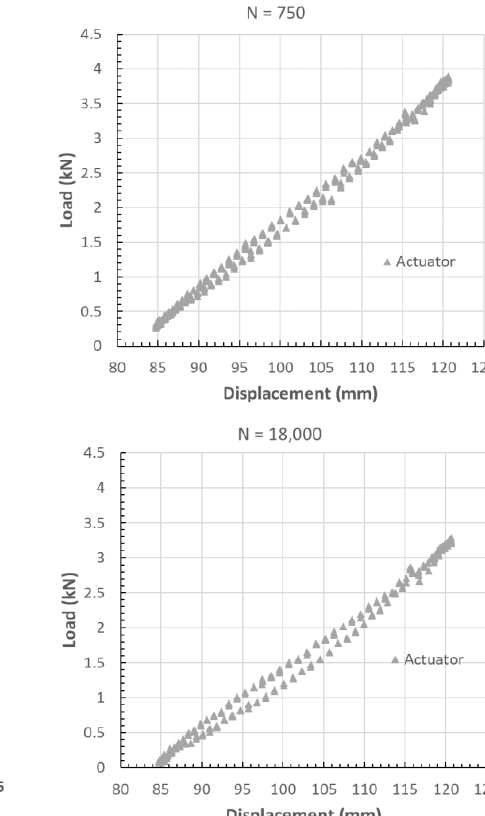
Figure 11. Load – displacement curve at initial cycles.